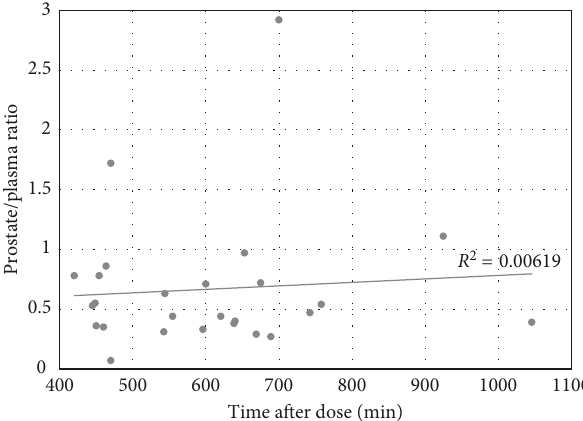
Figure 1: Prostate/plasma ratios after administration of a single 3g dose of oral